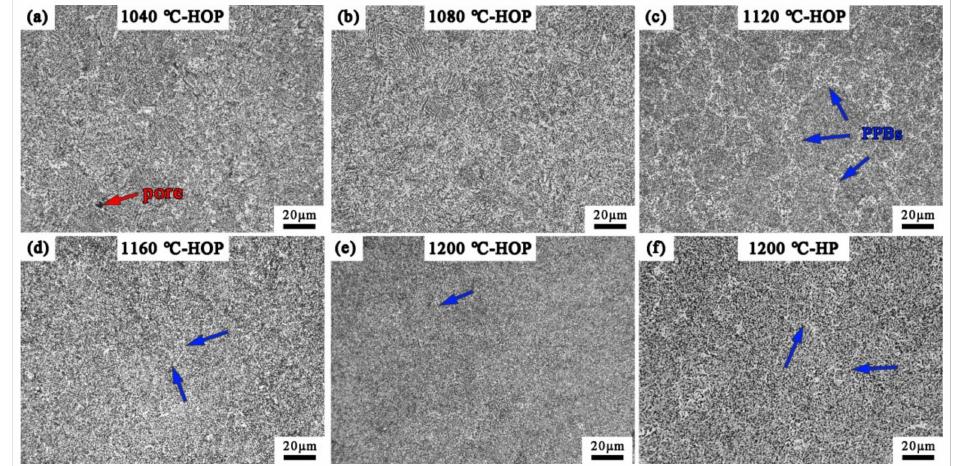
Figure 3. PPBs of the HOPed and HPed samples: ( a ) 1040 ◦ C-HOP; ( b ) 1080 ◦ C-HOP; ( c ) 1120 ◦ C-HOP;